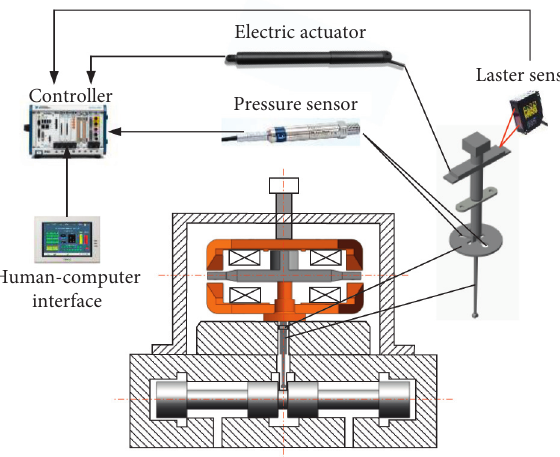
Figure 6: Schematic diagram of the test system.